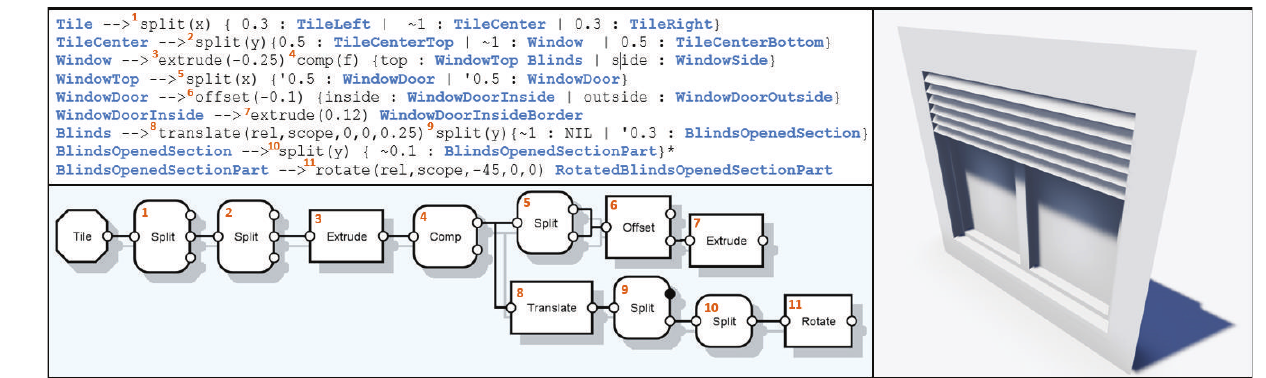
Figure 2: Window example modeled using a CGA shape grammar formulation (upper left; loosely based on [3] and [38]) and our procedural content graphs (lower left), each rule operation corresponding to a node with a matching number. The visual nature of our approach makes the flow of data easier to follow and does not require the user to come up with rule symbols (highlighted in blue) or geometric labels [6, 7], which generally make management difficult and